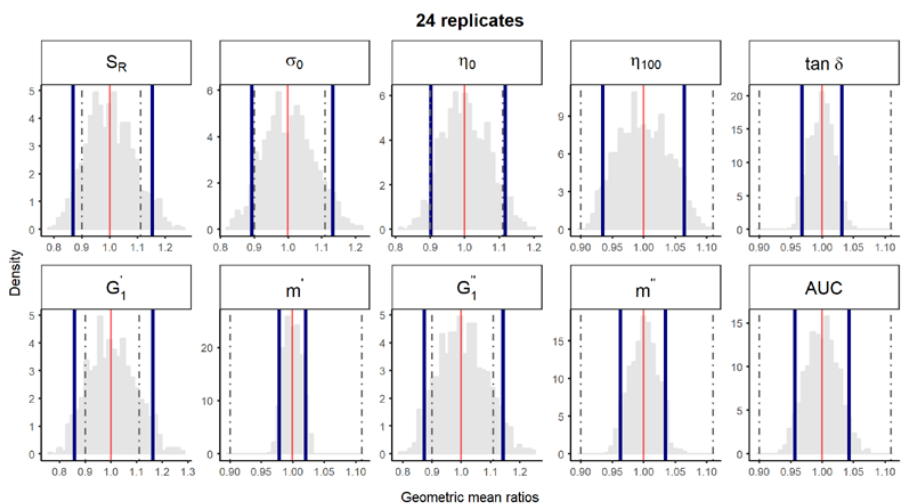
Figure S5. Bootstrap analysis of rheological parameters using 24 replicates—5 reference batches versus 5 references batches. A total of 10,000 geometric mean ratios (light grey area) resulting from the bootstrap analysis of “5 reference batches versus 5 test batches” for each rheological parameter. Data of 10 batches and 24 replicate each were used. Median (solid red line) and non-parametric 90% CI (solid blue lines) of the probability distribution. Dashed lines represent the acceptance limits for equivalence (90%–111.11%) stated in the EMA guideline [11]. S R , relative thixotropic area; σ 0 , yield stress; η 0 , zero-shear viscosity; η 100 , viscosity at 100 s −1 ; tan δ , loss tangent at 1 Hz; , calculated elastic modulus; 1′ , calculated viscous modulus; m' and m" are the parameters obtained when fitting G' and G'' , respectively, versus frequency; AUC , area under the weight versus surface curve (spreadability).